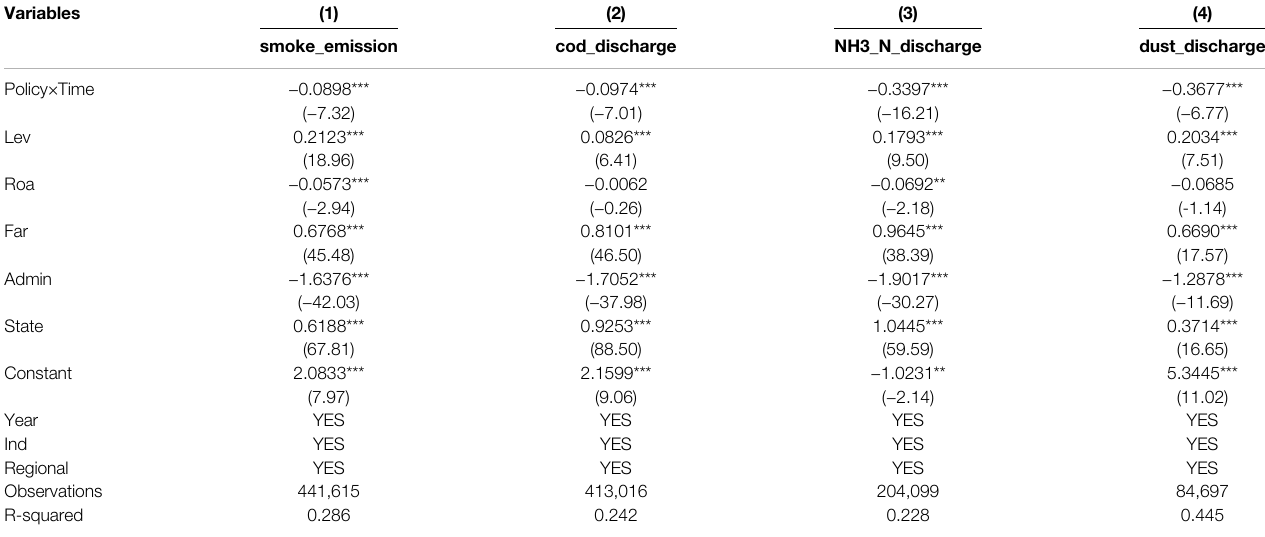
TABLE 8 | The green credit policy and other pollutant emission.